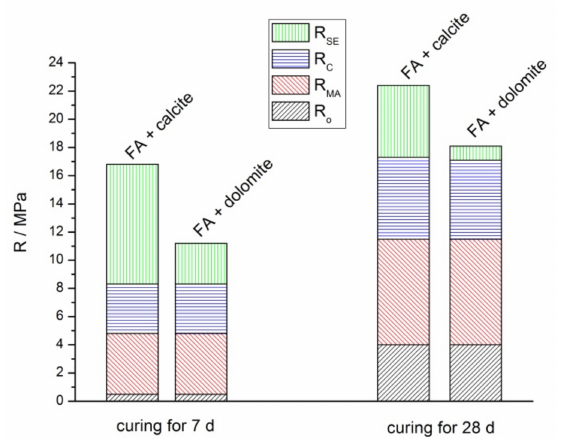
Figure 9. The increments of R o , R MA , R C , and R SE in the strength of geopolymers based on the 90% FA + 10% calcite and 90% FA + 10% dolomite blends mechanically activated for 180 s at the age of 7 and 28